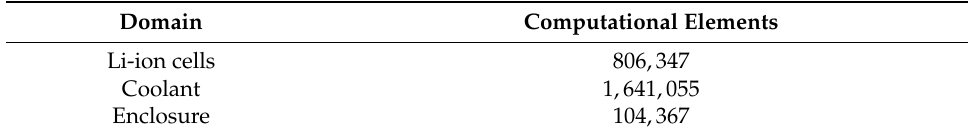
Figure 3. Numerical mesh employed for the numerical simulations of ( a ) immersion cooling, and ( b ) cold-plate cooling. Table 5. Computational elements in the medium grid for immersion cooling.